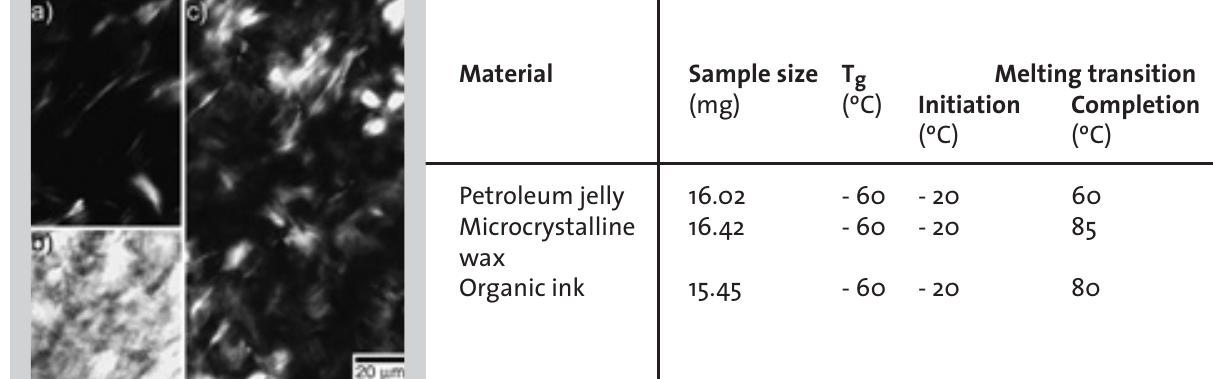
Figure 1 (left above): Polarized (crossed polariz- ers) optical microscope images of a) petroleum jelly, b) microcrystalline wax, and c) organic ink (1.5:1 blend a:b).